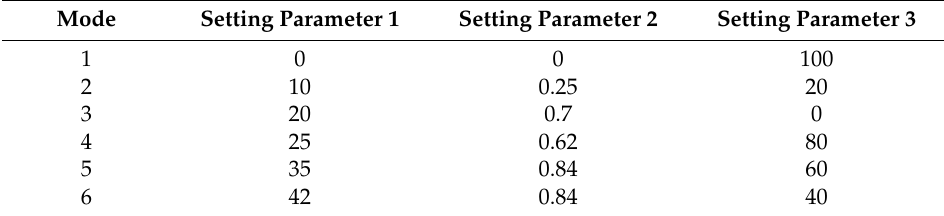
Figure 3. The simplified schematic illustration of the aircraft engine model [37]. Table 1. Six different operation modes (steady state of engine operation).